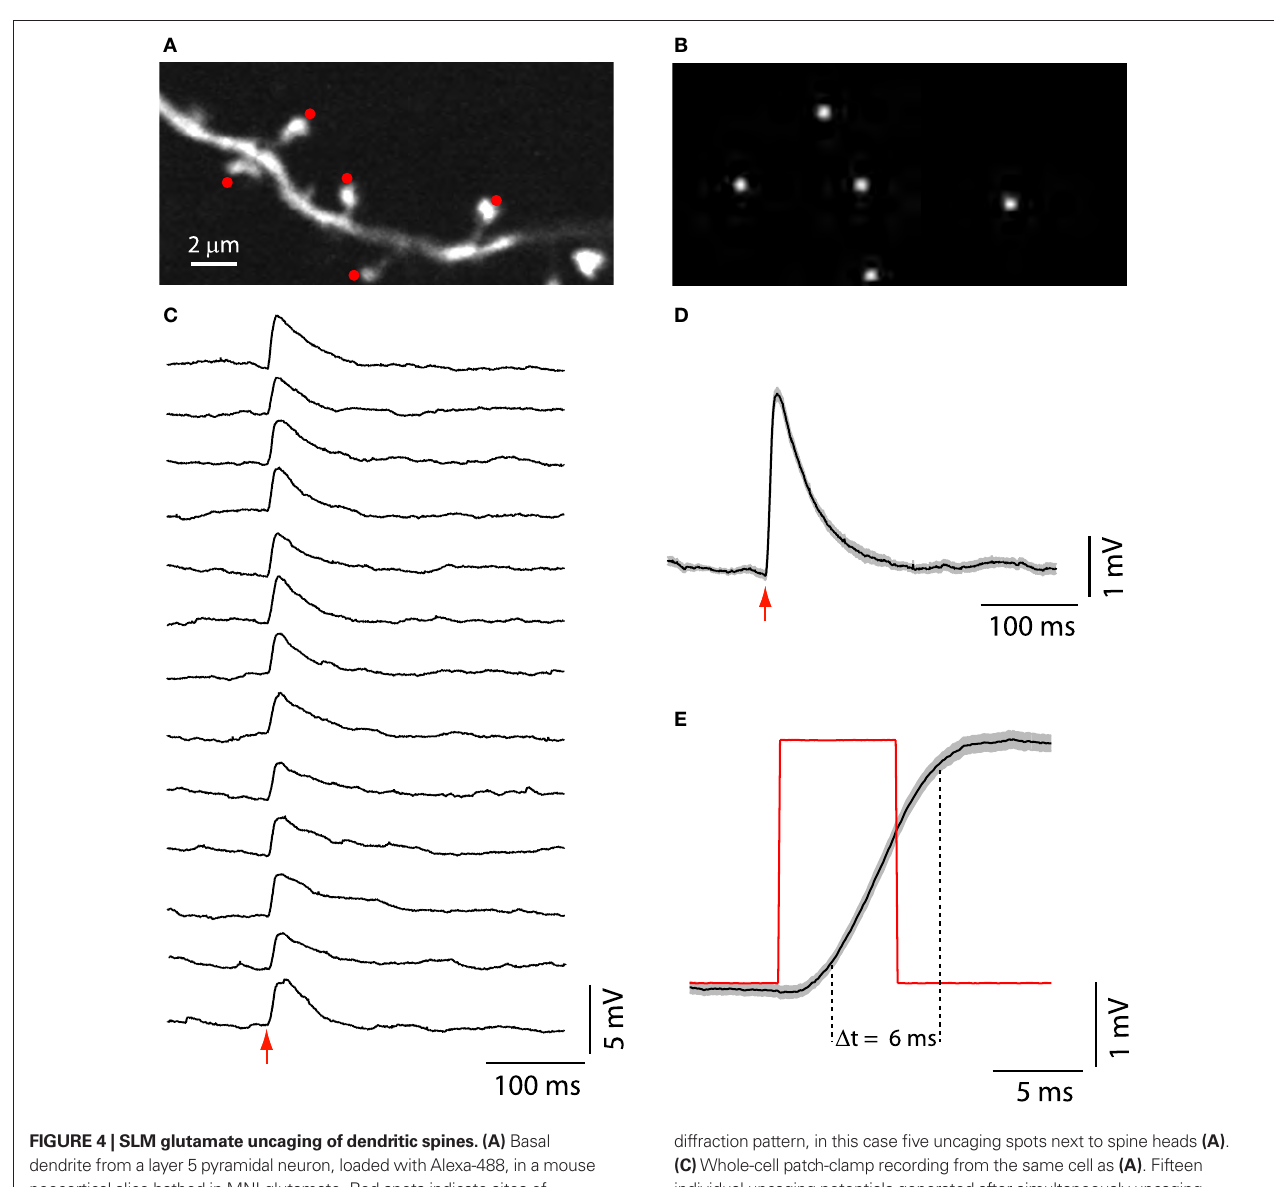
FIGURE 4 | SLM glutamate uncaging of dendritic spines. (A) Basal dendrite from a layer 5 pyramidal neuron, loaded with Alexa-488, in a mouse neocortical slice bathed in MNI-glutamate. Red spots indicate sites of simultaneous uncaging. Image acquired with galvanometers raster scanning. (B) First, a bitmap fi le was generated with the uncaging locations selected in (A) ; then a Fourier transform of the image was set as the command to the spatial light modulator (SLM) to generate a phase mask and the desired